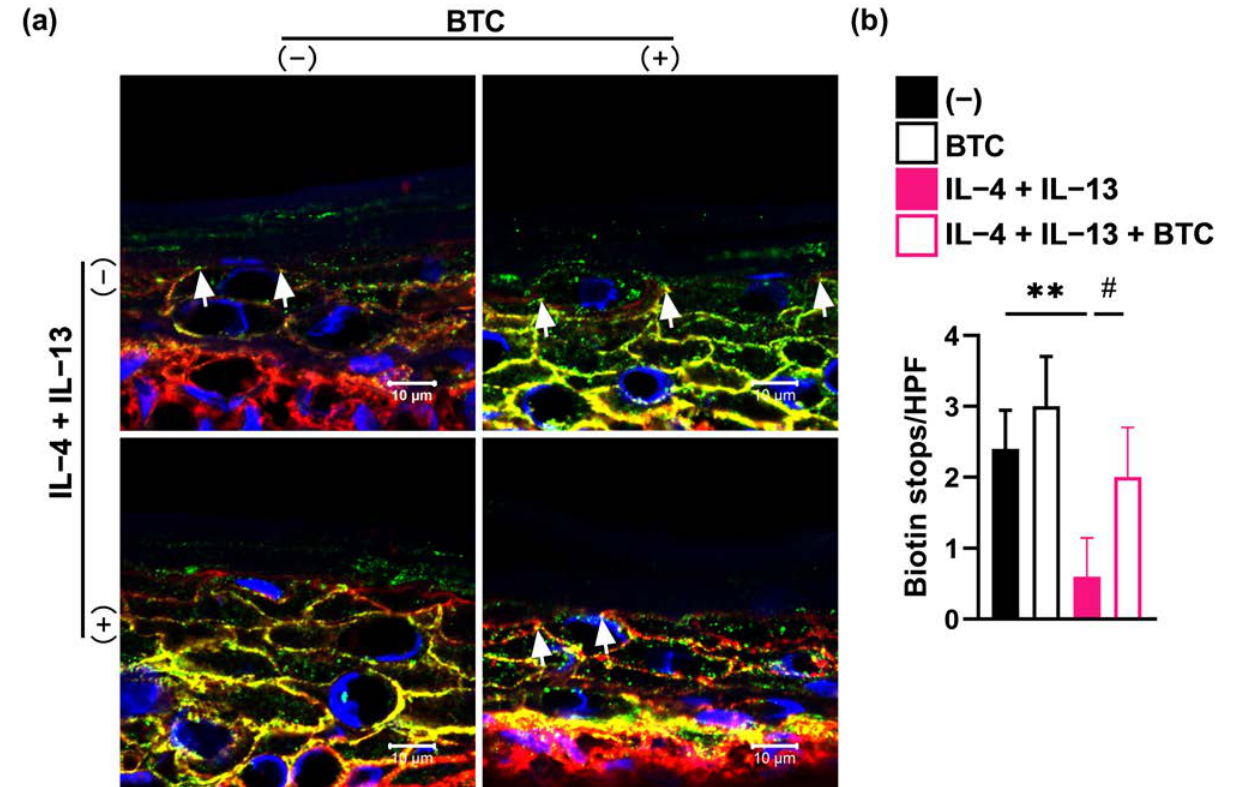
Figure 5. BTC addition leads to recovery of the Th2-type cytokine-mediated impairment of the skin barrier in skin equivalents. Representative immunofluorescence images ( a ) and quantification ( b ) of biotin tracer stops indicated by white arrows in the skin equivalent model, n = 4/group. Scale bar: 10 μm. ** p < 0.01, and # p < 0.05.